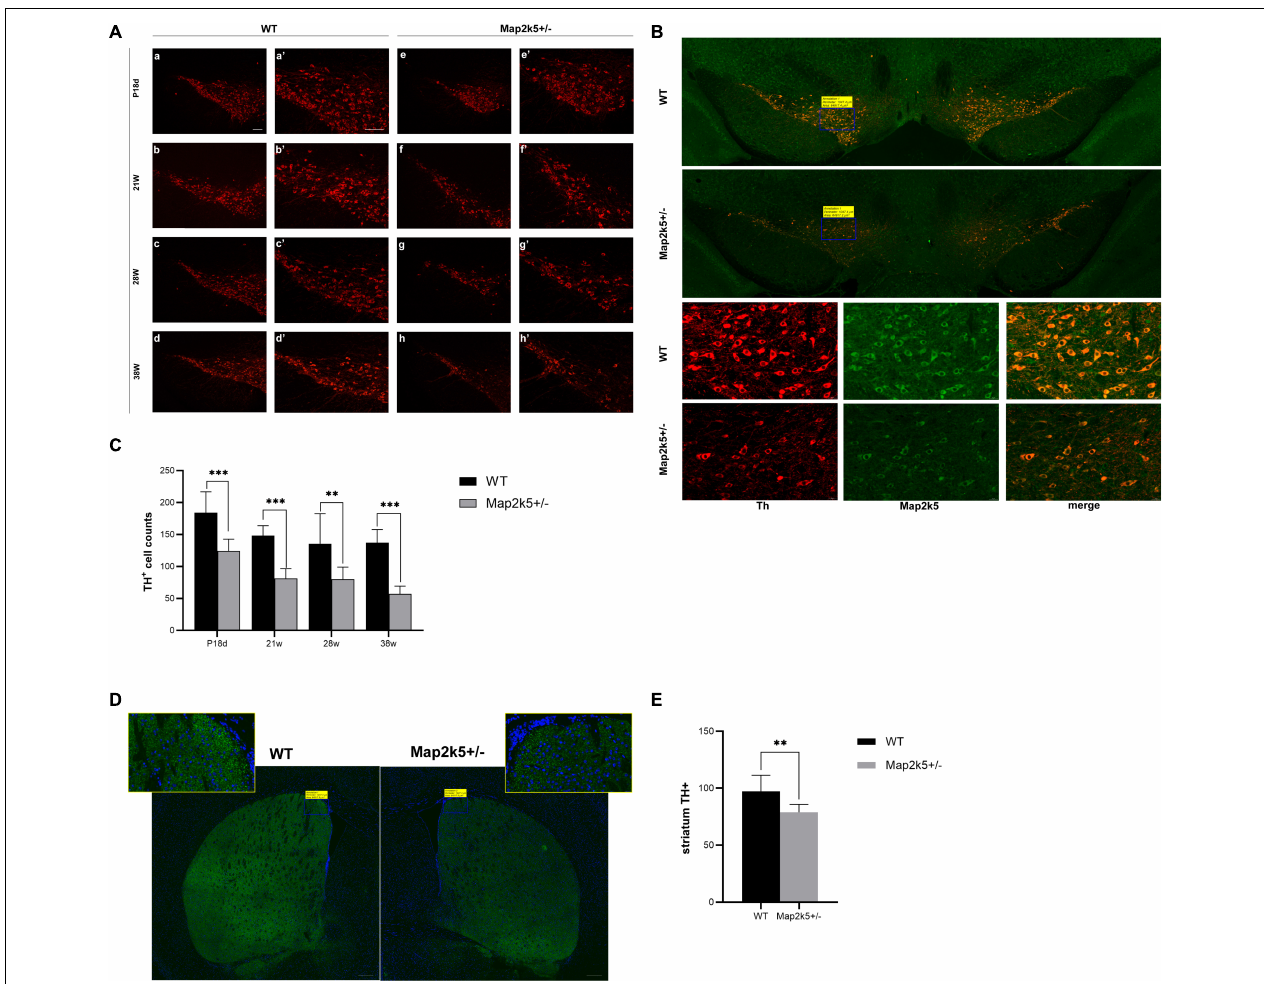
FIGURE 4 | (A) Coronal sections of substantia nigra pars compacta (SNc) were prepared from P18d, 21, 28, and 38 weeks and immunostained with an anti-TH antibody. Map2k5 + / − mutant mice had decreased TH + cell number in SNc at P18d, 21, 28, and 32 weeks. (a–d) Immunostained TH + cells in SNc of Map2k5 + / + WT mice (100x). (e–h) TH + cells in SNc of Map2k5 + / − mutant mice (100 × ). (a’–h’) High-magnification images (200 × ) of the corresponding section in (a–h). Scale bar, 100 µ m. (B) TH + and Map2k5 + -stained cells, and merged pictures of Map2k5 + / − mutant and WT mice in SNc of at 38 weeks. Low-magnification images (50 × ) and high-magnification images (400 × ). 200 µ m (50 × ), 20 µ m (400 × ). (C) TH+ cell counts in SNc were reduced in female Map2k5 + / − mutant mice compared with WT mice at P18d, 21, 28, and 38 weeks ( P 18d < 0.001, P 21w < 0.001, P 28w = 0.005, P 38w < 0.001). (D) Coronal sections of striatum immunostained with anti-TH antibody. We found decrease immunofluorescence in Map2k5 + / − mutant mice compared with WT mice. Low-magnification images (50 × ) and high-magnification images (630 × ). Scale bar, 200 µ m (50 × ), 20 µ m (630 × ). (E) Mean immunofluorescence intensity of each slice was analyzed. There